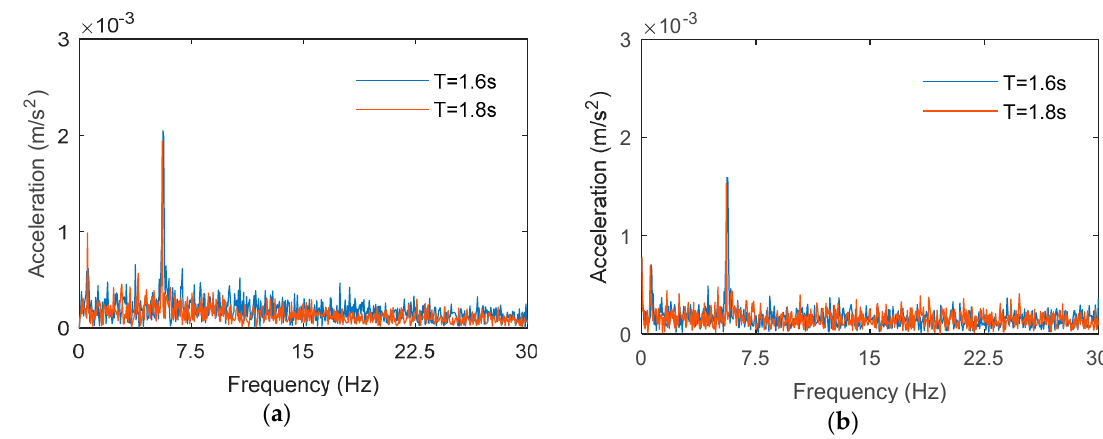
Figure 10. The peak accelerations at various measurement positions in waves. ( a ) Variation with wave height when wave period T = 1.6 s; ( b ) Variation with wave period when wave height H = 0.15 m.